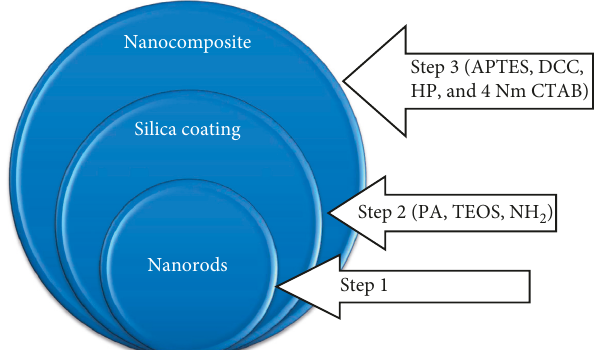
Figure 22: Scheme of the fabrication of AuNRs/SiO isopropyl alcohol; TEOS, tetraethyl orthosilicate; APTES, 3-ami- nopropyltriethoxysilane; HP, hematoporphyrin; DCC, dicyclo- carbodiimide; CTAB, cetyltrimethylammonium bromide